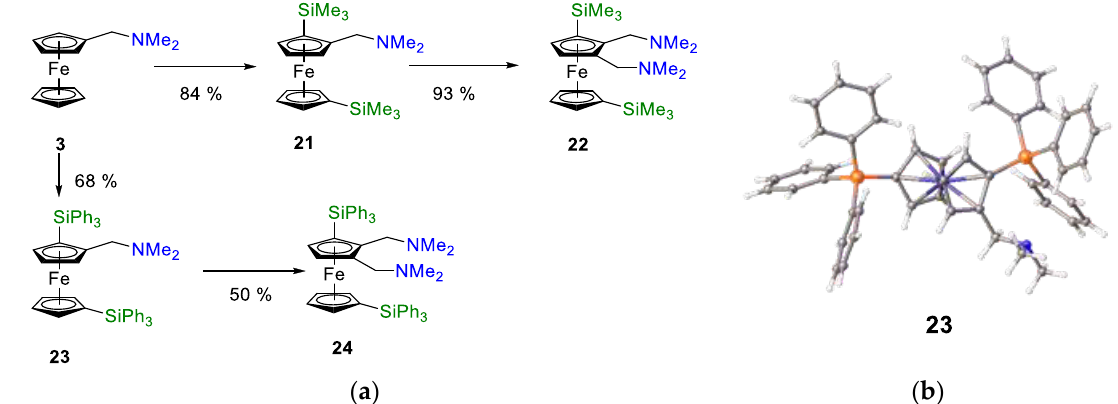
Figure 11. ( a ) Synthetic route to multiply substituted ferrocenyl-alkylamines. Individual reaction steps involve lithiation, followed by quenching with ClSiPh 3 , ClSiMe 3 , or Eschenmoser’s Salt. ( b ) ORTEP diagram of 2-(N,N ′ -dimethylaminomethyl)-1, 1′ -bis-triphenylsilylferrocene, 23 . Ellipsoids are at 50% probability, and hydrogen atoms are removed for clarity.